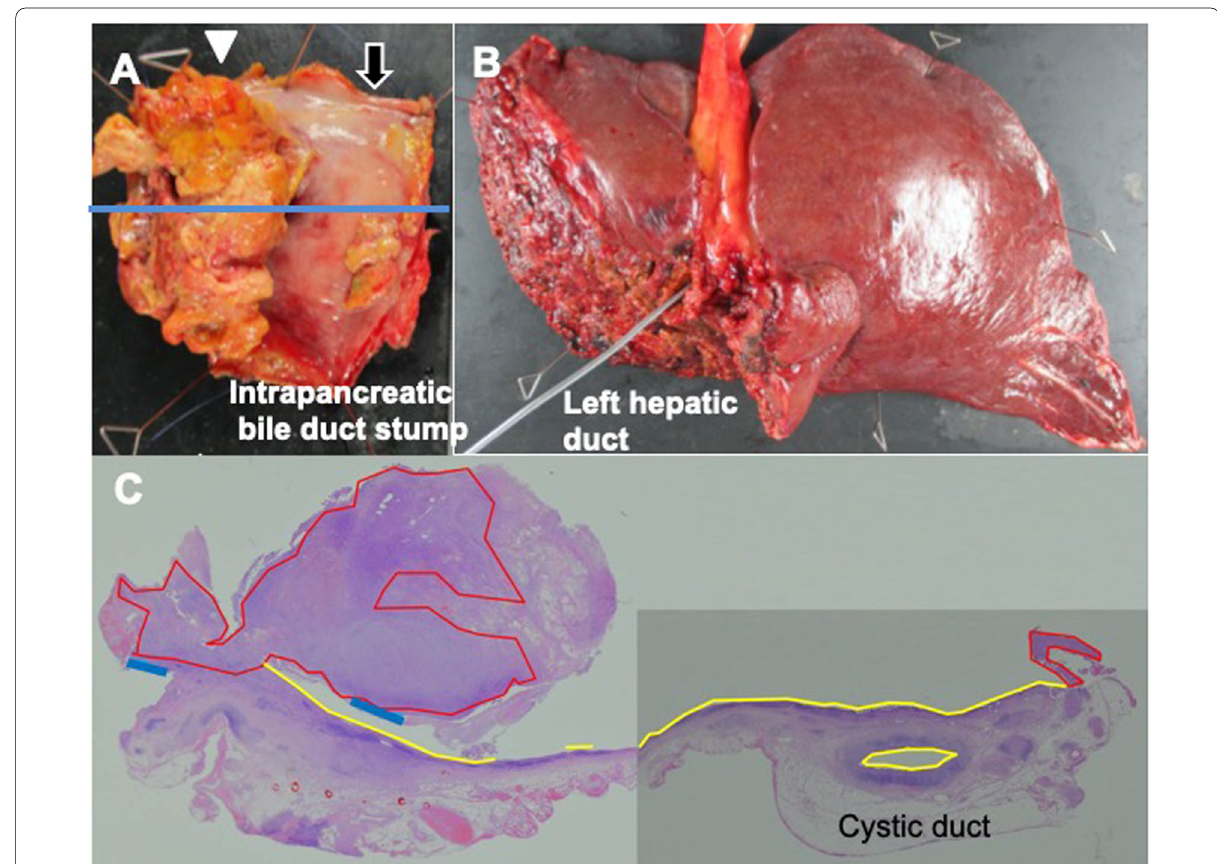
Fig. 3 Resected specimen of the extrahepatic bile duct. The stumps of the intrapancreatic bile duct and right hepatic duct (black arrow) were negative for malignancy. Invasive cancer was observed at the stump of the left hepatic duct (white arrowhead). The blue line shows the slice of ( A ). Biliary intraepithelial neoplasm-3 was widely observed in the left intrahepatic bile duct ( B ). The protruded tumor mainly consisted of undifferentiated carcinoma (red) and a differentiated component located in the peripheral of the nodule (blue). High-grade biliary intraepithelial neoplasms (BilIN-3) were observed around the nodule (yellow) ( C